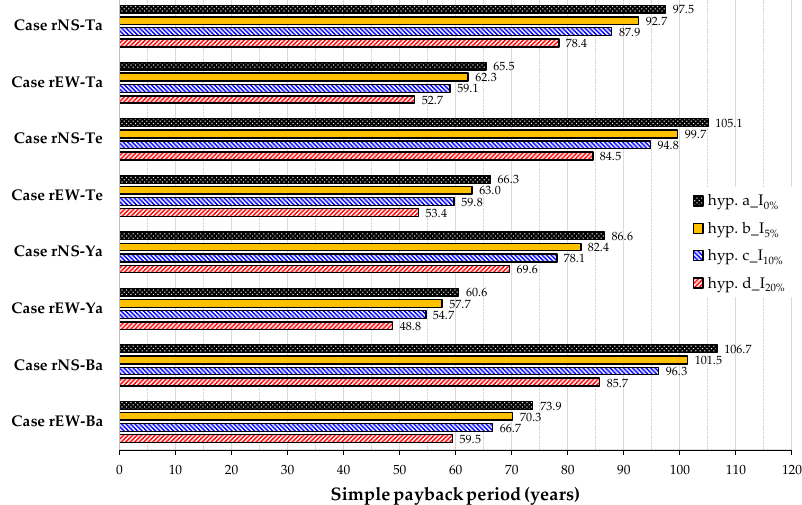
Figure 9. Simple payback period according to case study and incentives’ hypotheses. Figure 9 highlights that: